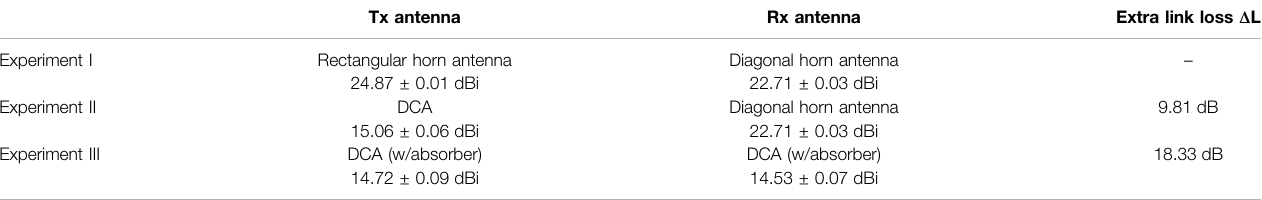
TABLE 2 | Antennas and additional link losses in the three transmission experiments.